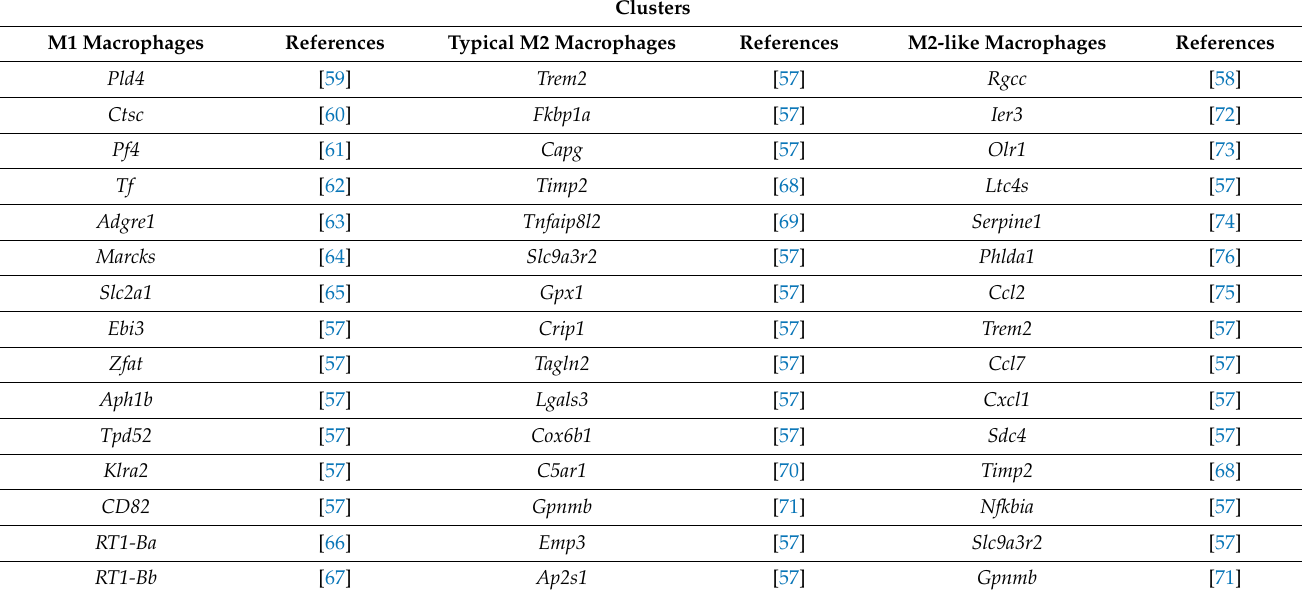
Table 2. Macrophage polarization: different gene signatures in M1, typical M2, and M2-like macrophages. Clusters